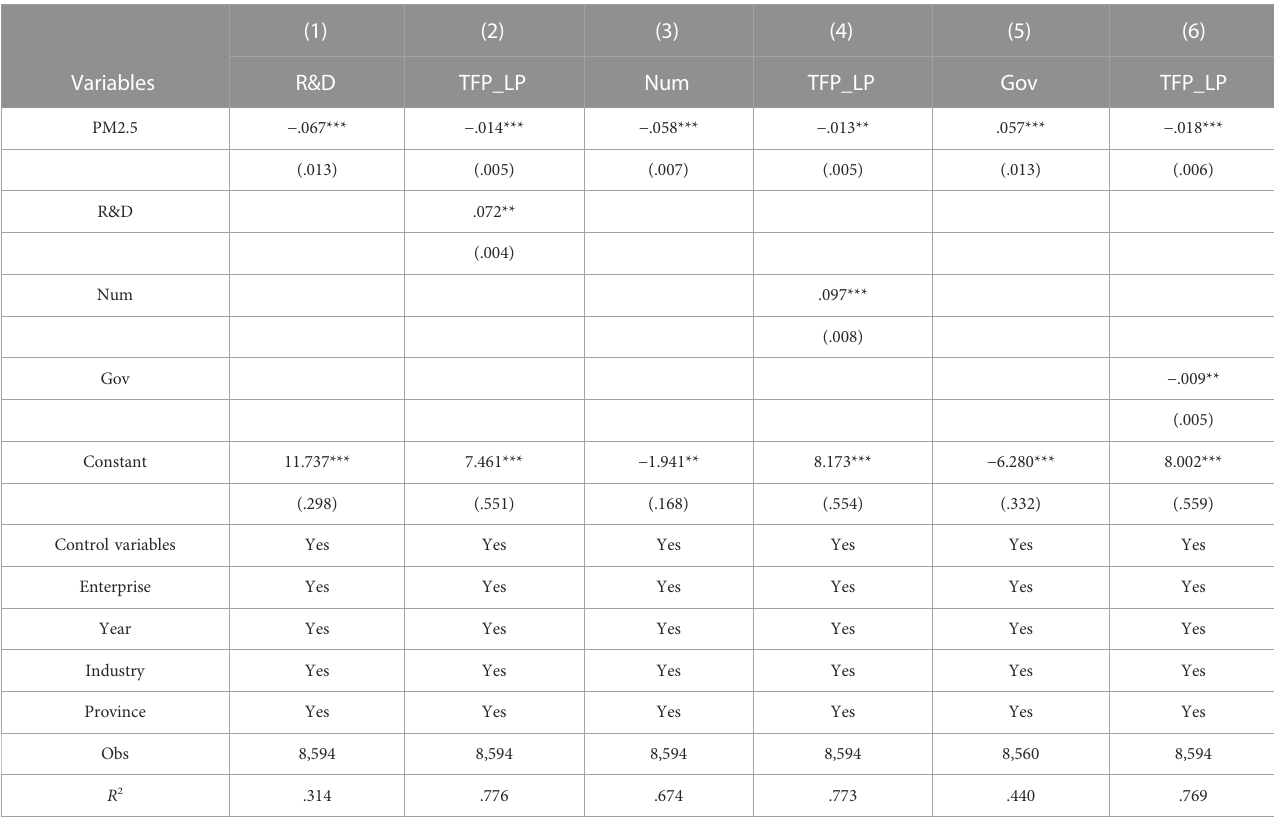
TABLE 10 Mechanism